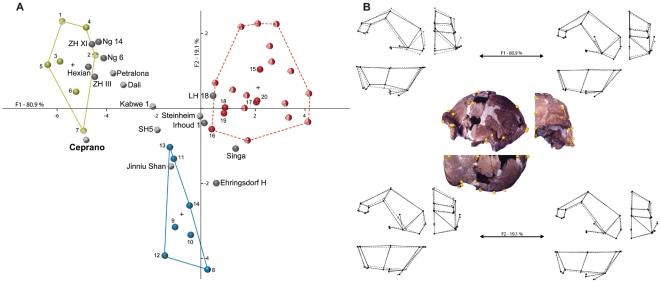
Discriminant Function Analysis based on landmarks data (A) and associated cranial shapes (B).A) Crosses indicate centroïds of each a priori sample. Red spheres  =  modern humans (plain, fossil specimens; stripe, Holocene specimens); blue spheres  =  Neandertals; green spheres  =  Early Pleistocene composite sample (plain, African specimens; stripe, Eurasian specimens); gray spheres  =  fossils included a posteriori in the analysis (stripe spheres are specimens that cluster with Ceprano in the dendrograms of Figure 2). B) The configuration of landmarks is indicated by yellow circles superimposed on views of the Ceprano cranium (full, visible landmarks; empty, landmarks non visible in the current view); shapes in norma lateralis (upper left), norma verticalis (lower left) and norma facialis (right) are portrayed for the extremities of each axis (full lines, shape change; dashed lines, consensus). Modern humans, Neandertals and Early Pleistocene specimens are well-discriminated on Function 1. Function 2 discriminates modern humans and Early Pleistocene specimens from Neandertals. The architectural shape of Ceprano is closer to Early Pleistocene specimens and, particularly, to Sangiran 17 from Java (7). Due to the apparent deformation of both Steinheim and Jinniushan, their respective positions in the graph are at least questionable.